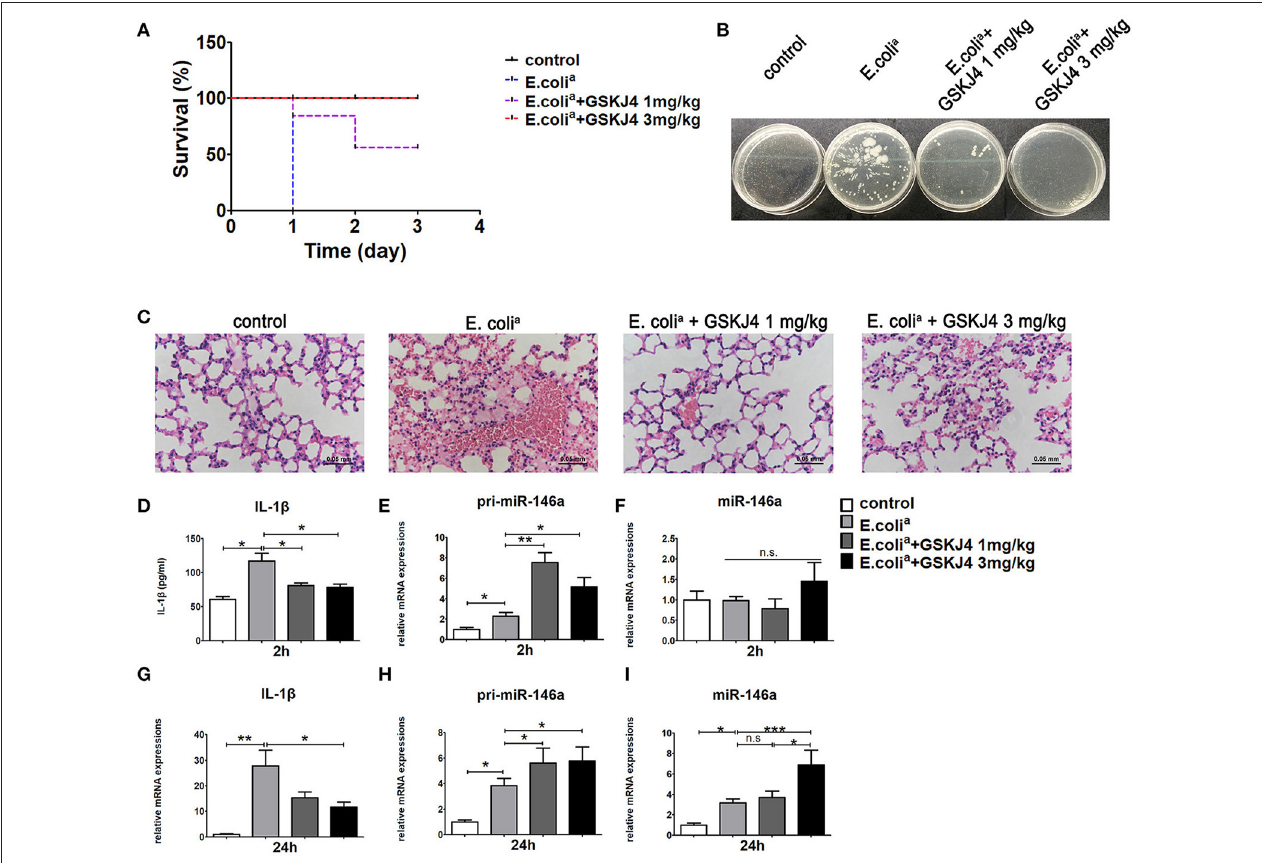
FIGURE 1 | GSKJ4 protects mice against septic death. ICR mice were administered intraperitoneally (i.p.) with GSKJ4 (1 or 3 mg/kg body weight) or normal saline 1h prior to bacterial infection intraperitoneally (i.p.) with viable clinical Escherichia coli ( E. coli a ) (5 × 10 7 CFU/mouse). (A) Mouse survival was monitored every day. Survival curves were used to analyze the data (7 mice per group). (B–I) Mice were treated as in (A) except that mice were injected (i.p.) with E. coli a (1 × 10 7 CFU/mouse). (B) Blood from mice 24h after infection was plated for 16h. Representative plate shows bacterial colonies. (C) Representative Hematoxylin and eosin (H&E) stain of lung sections of mice 24h after infection. (D) The serum level of IL-1 β at 2h post bacterial infection was measured by ELISA kit (7 mice per group). The mRNA expression levels of pri-miR-146a (E,H) , miR-146a (F,I) , and IL-1 β (G) in peritoneal macrophage were determined by quantitative PCR (7 mice per group). Data are shown as mean ± SEM ( n = 7). * P < 0.05; ** P < 0.01; *** P < 0.001.